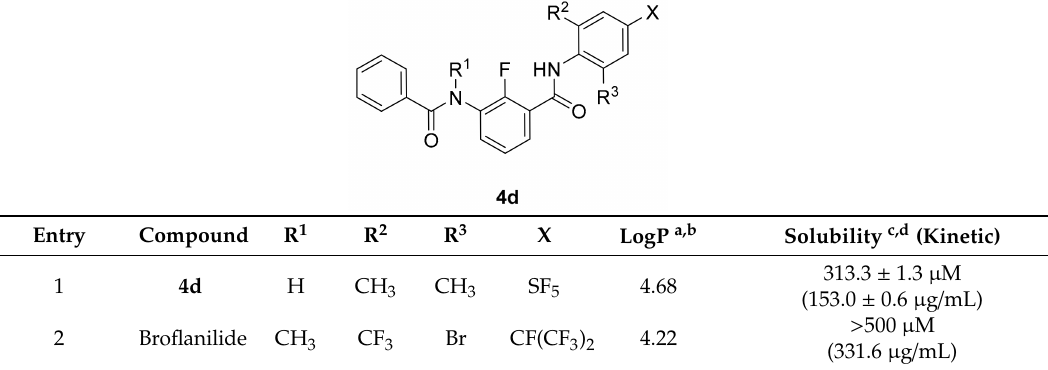
Table 3. Physical properties of SF 5 -containing meta-diamide insecticide 4d